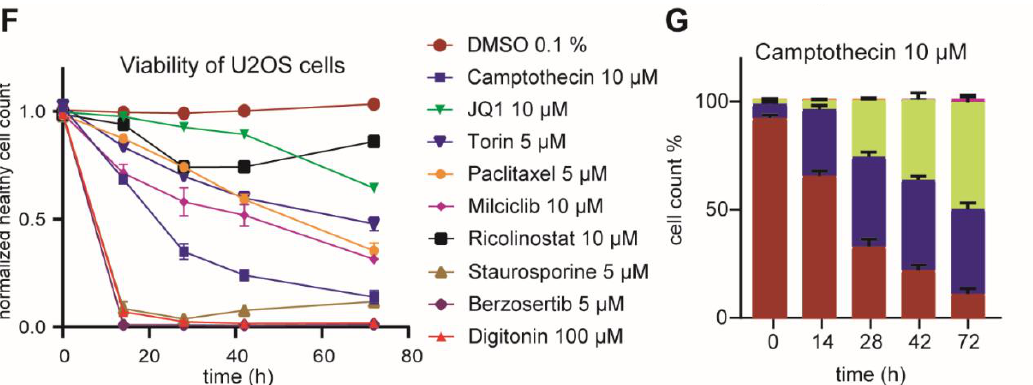
Figure 1. Validation of cell staining dyes and optimization of High-Via Protocol. ( A ) Healthy cell count after 90 h of cell staining dye exposure at six different concentrations and 10 µ M of staurosporine in U2OS cells. Vertical lines show optimal concentration used in subsequent assays (Hoechst33342 60 nM (ThermoFisher, Waltham, MA, USA), MitoTracker TM red 75 nM (Invitrogen, Waltham, MA, USA), MitoTracker TM far red 75 nM (Invitrogen, Waltham, MA, USA), YoPro3 1 µ M (Invitrogen, Waltham, MA, USA), BioTracker Microtubule 3 µ M (EMD Millipore, Burlington, MA, USA). Error bars show SEM of four technical replicates. ( B ) Healthy cell count 0 h, 12 h, 24 h, 48 h and 72 h after cell staining dye exposure alone or in combination (Multiplex: Hoechst33342 60 nM, BioTracker TM